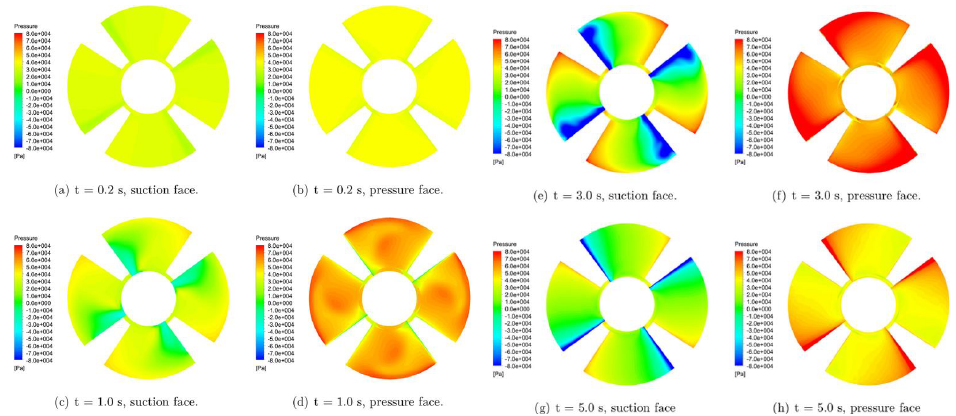
Figure 4. Pressure change on impeller during startup [16].